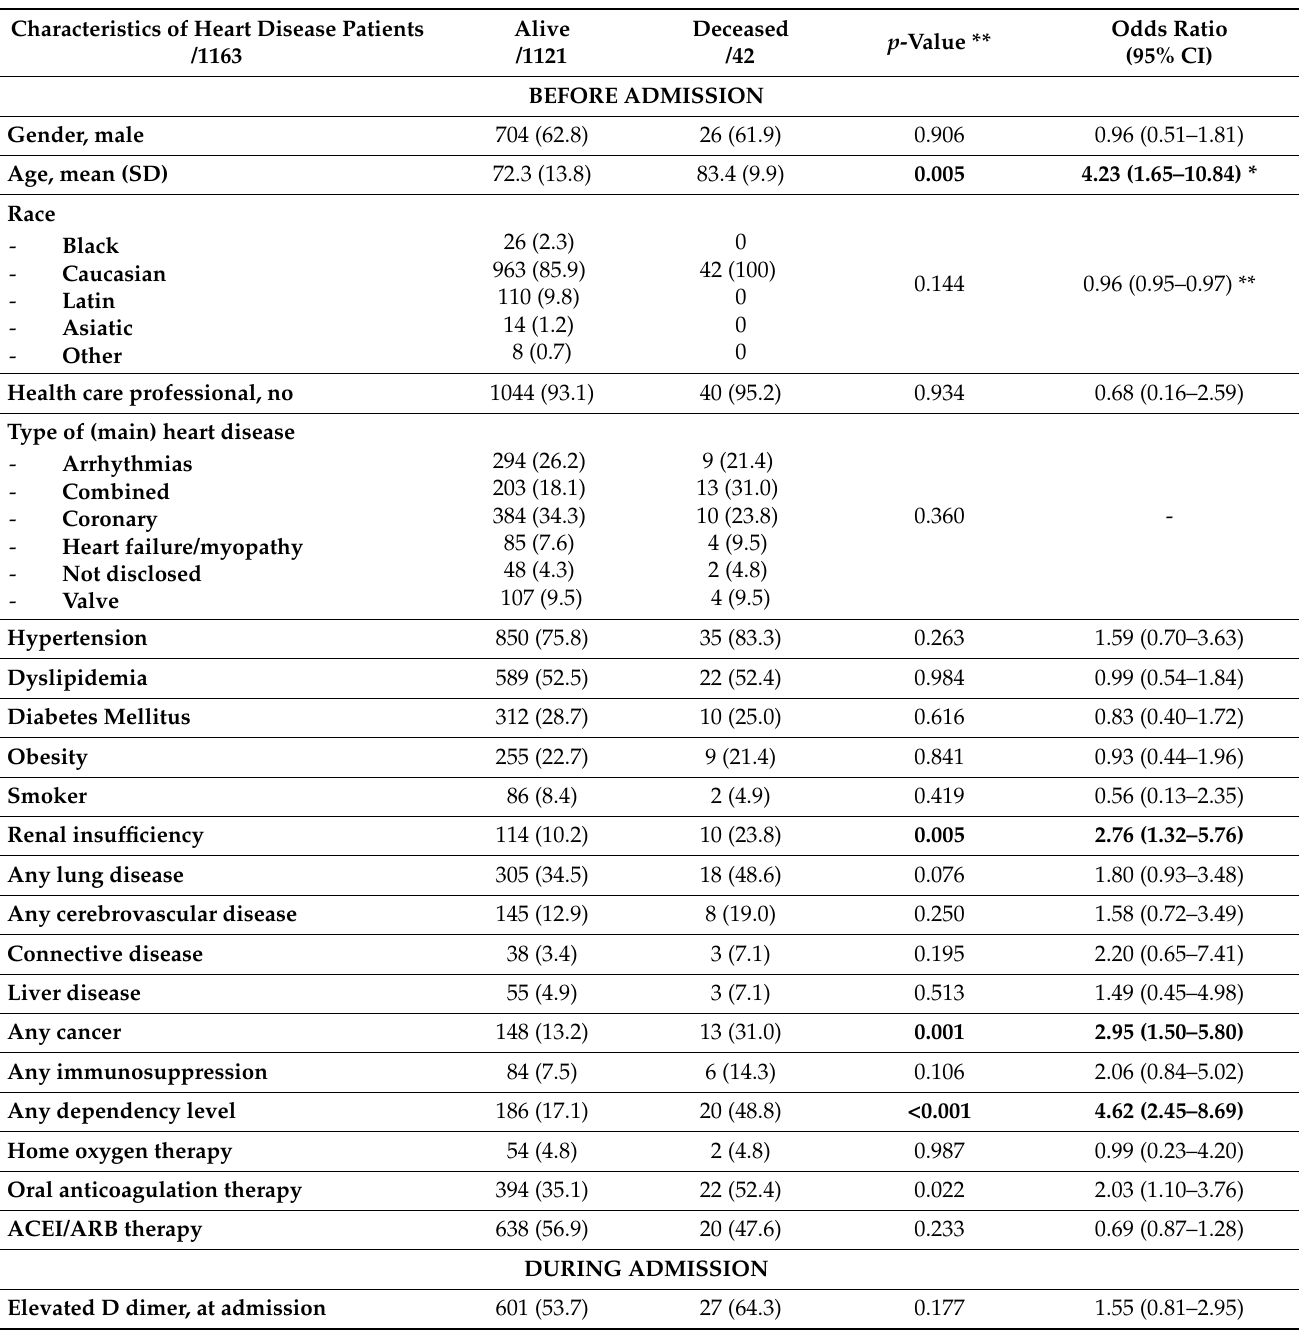
Table 2. Clinical features of patients with any underlying heart disease before admission, discharge management, and vaccination stratified by vital status after a mean follow-up. Data presented over available registries in each variable (percentages). All these patients were discharged alive. p < 0.05 variables, before admission, were included in the multivariate model (see text). Univariate risk estimators (odds ratio (OR) and the corresponding 95% confidence interval) are provided. * Comparing age <70 vs. ≥ 70 years old. ** Caucasian vs. no Caucasian. *** Any chest X-ray abnormality